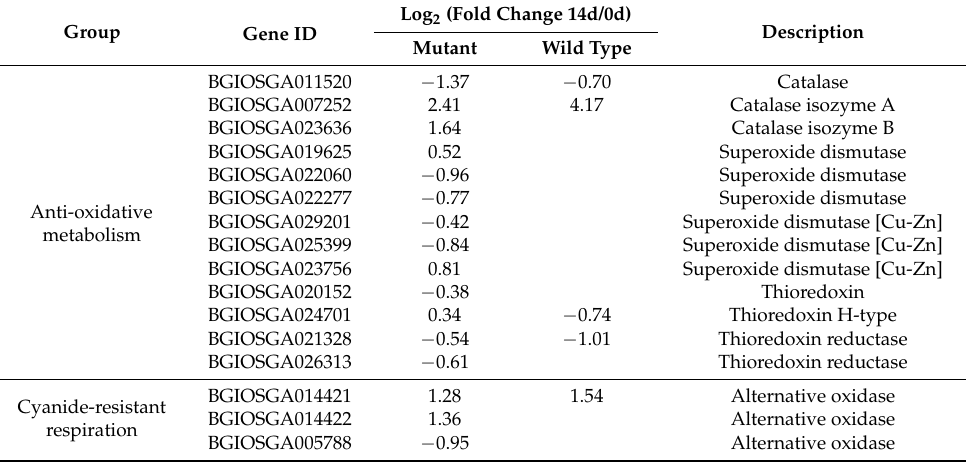
Table 7. Genotypic differences in expressions of DEGs encoding proteins involved in antioxidative metabolism and cyanide-resistant respiration between the initial and 14th day of the grain-filling stage (padj <